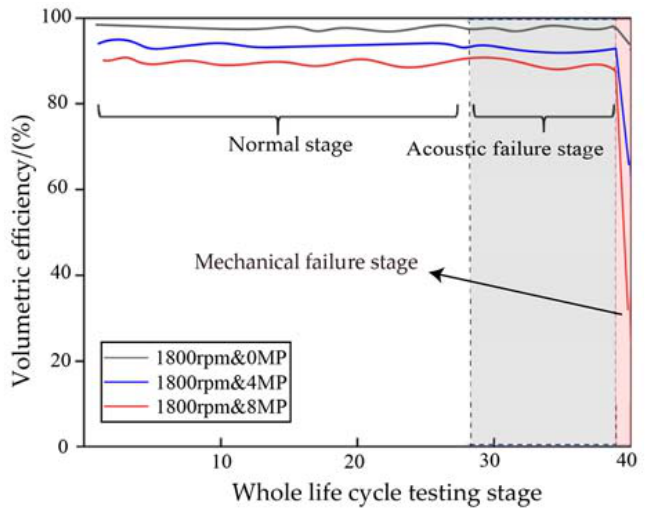
Figure 5. Full life variation curve of the volumetric efficiency of internal gear pumps.